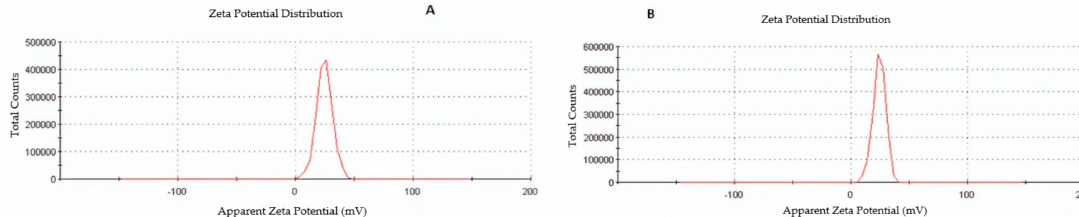
Figure 4. Zeta potential images of ( A ) placebo chitosan nanoparticles and ( B ) rotigotine-loaded chitosan nanoparticles.